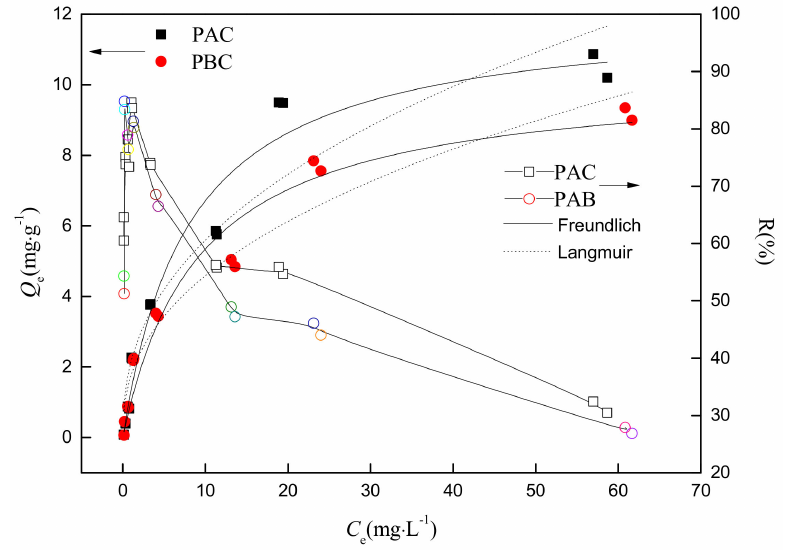
Figure 5. The adsorption isotherm and the adsorption percentage of Sr by adaxial (PAC) and abaxial